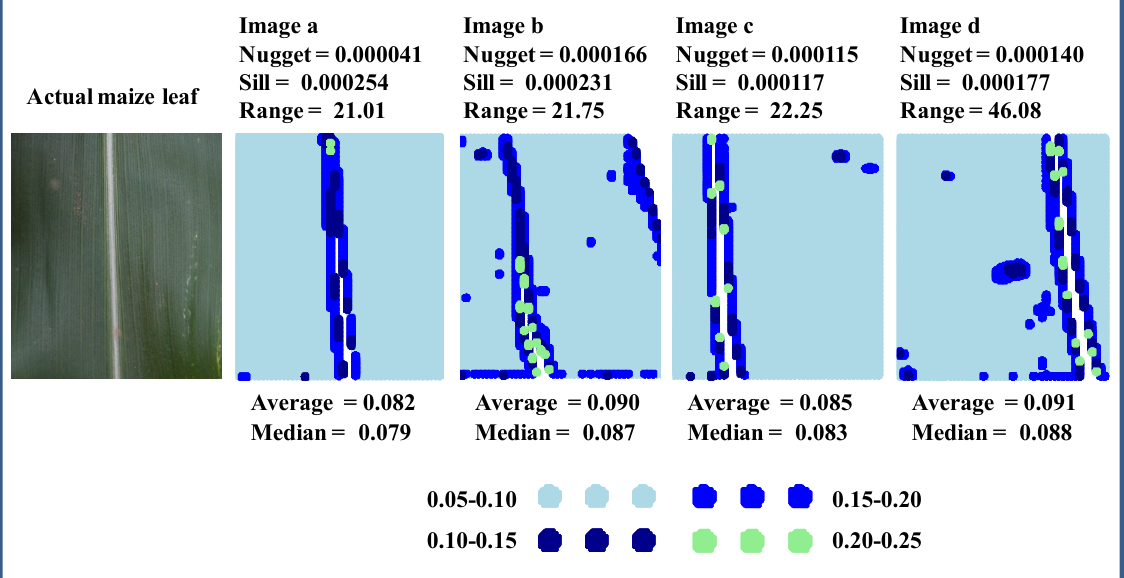
Figure 5. Maize leaf images: an actual RGB image and 4 images based on reflectance values at 683 nm with each image representing 10,000